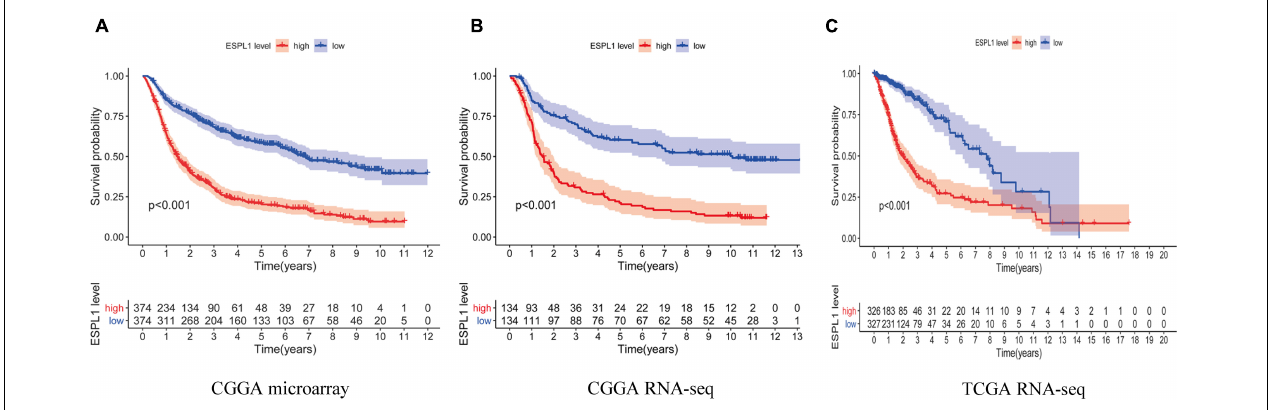
FIGURE 2 | The relationship between the difference of the expression level of ESPL1 and overall survival (OS). The red curve in the figure represents the ESPL1 high expression group, and the blue curve represents the ESPL1 low expression group. (A) CGGA RNA-seq dataset. (B) CGGA microarray dataset. (C) TCGA RNA-seq dataset.